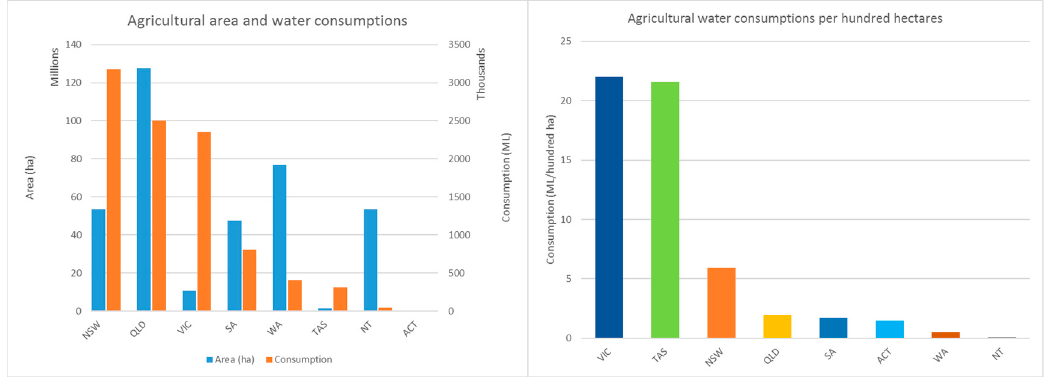
Figure 5. Land use and water consumption for agricultural production.